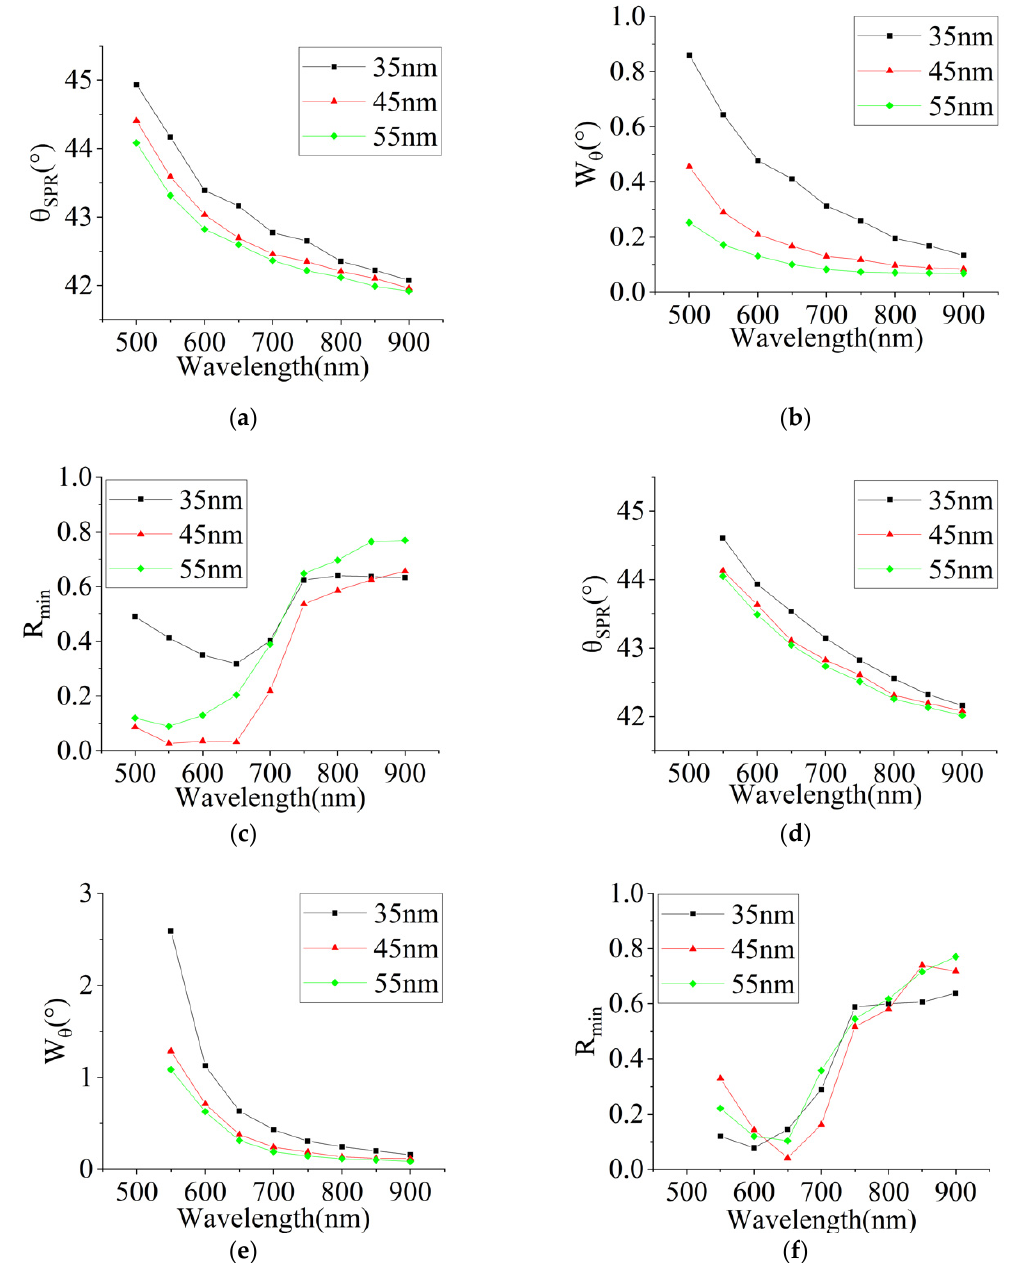
Figure 7. The minimum reflectivity, resonance angle, and FWHM measurement results of silver ( a–c ) and gold ( d–f ) films.